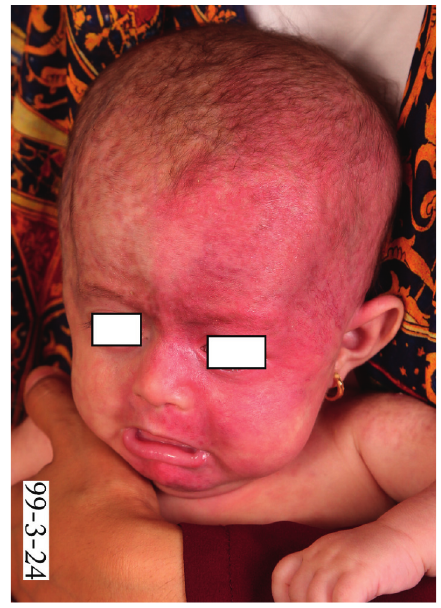
Figure 1: Extensive port-wine stain since birth.